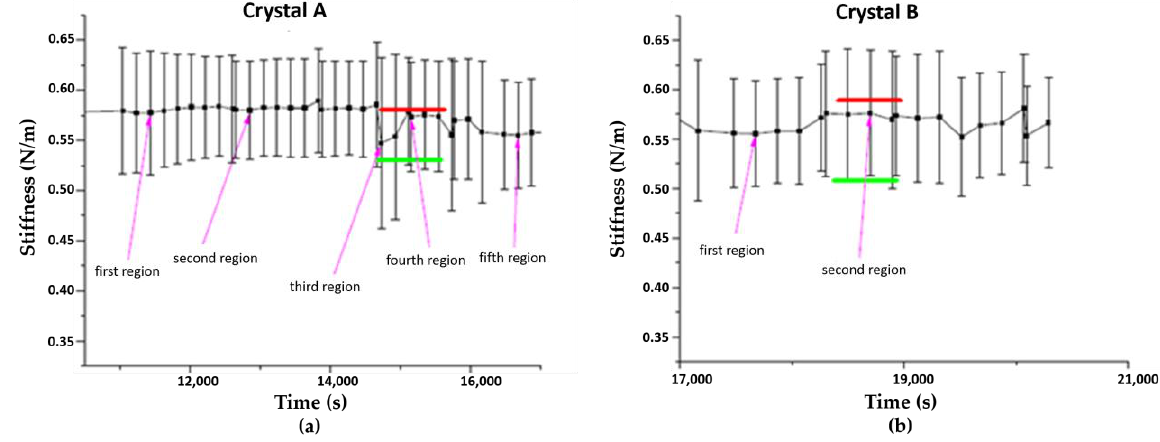
Figure 8. Comparison of the measured stiffnesses of different regions randomly chosen on two crystals named A ( a ) and B ( b ), in PBS at pH = 5.4. Results were averaged over regions of 1 µ m 2 .